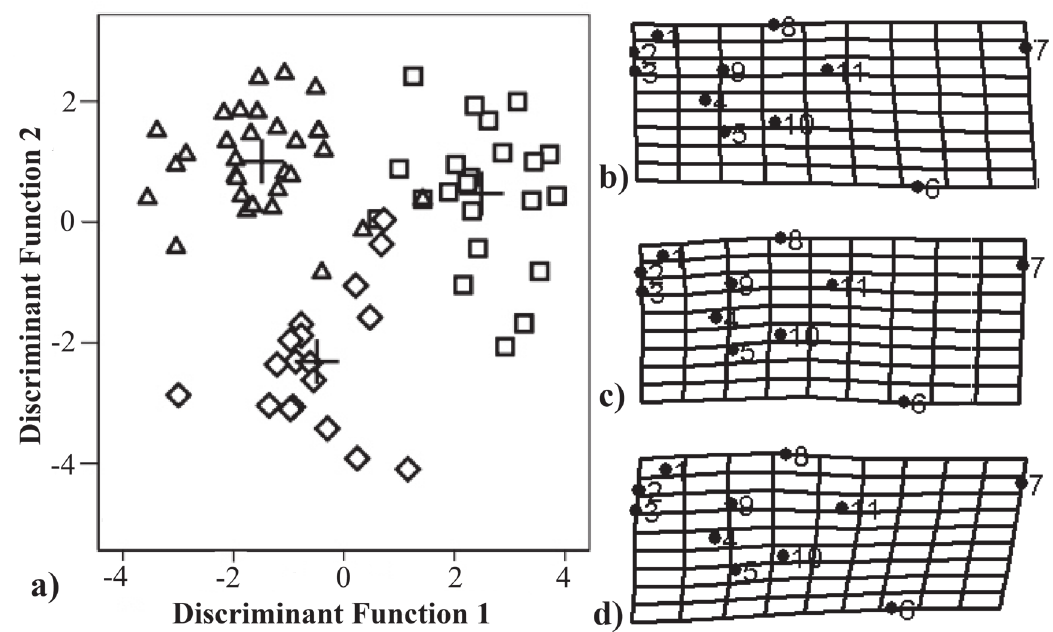
Fig. 8. a ) Discriminant function 1 versus discriminant function 2 for head shape of just captured individuals (squares), individuals fed with Tubifex sp. for 60 days (triangles), and individuals fed with Tubifex for 240 days (diamonds). Deformation grids correspond to ( b ) just captured individuals, ( c ) individuals fed with Tubifex sp. for 60 days, and ( d ) individuals fed with Tubifex sp. for 240